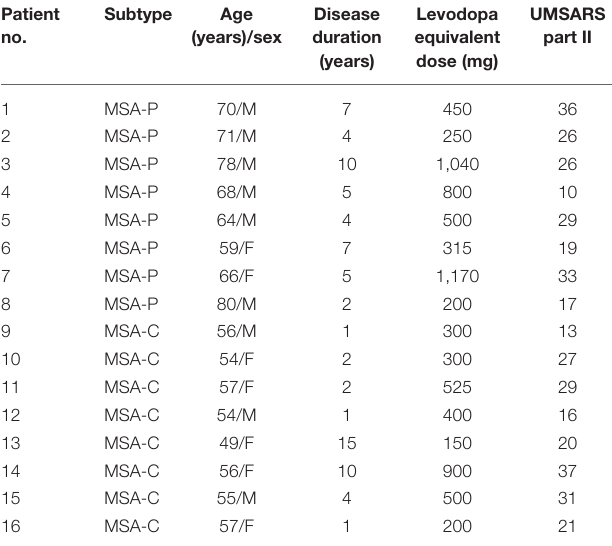
TABLE 1 | Demographic data of patients with multiple system atrophy (MSA). Patient